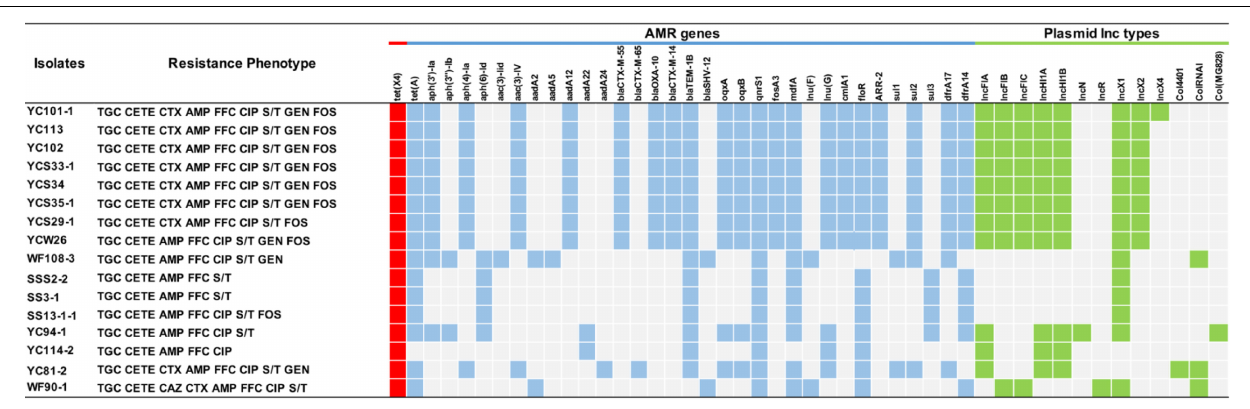
FIGURE 2 | Antimicrobial resistance profiles of tet (X4)-positive E. coli isolates and the presence or lack of AMR genes are colored in blue or gray, respectively. The red squares indicate the presence of tet (X4) gene. The green squares indicate the plasmid type. TGC, tigecycline; CETE, chlortetracycline; MEM, meropenem; CAZ, ceftazidime; CTX, cefotaxime; AMP, ampicillin; CIP, ciprofloxacin; S/T, trimethoprim/sulfamethoxazole; GEN, gentamicin; AMK, amikacin; FOS, fosfomycin; CS, colistin. The breakpoint of CETE is not available, so resistance to CETE was defined regarding the resistant breakpoint of tetracycline ( ≥ 16 mg/L) (CLSI,